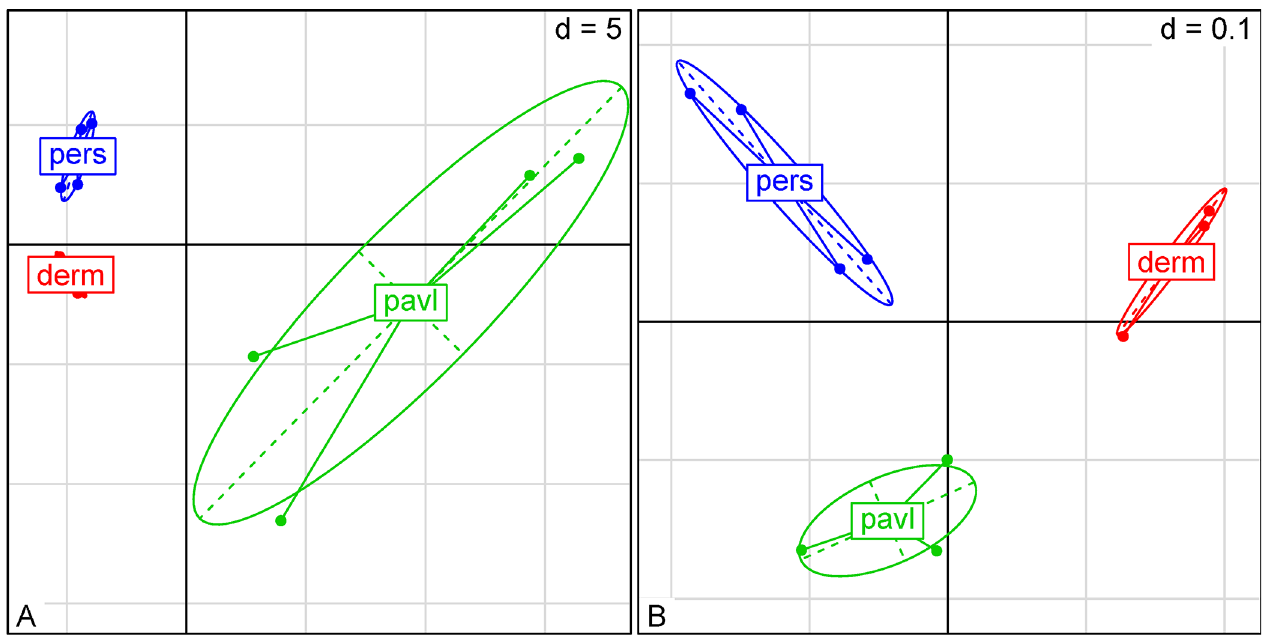
Fig 2. Between-class analysis plots for taxon-based distances. A) MDS plot based on PCA for 150 taxa with the largest share. Principal component analysis was performed using package “ ade4 ” with data scaling and centering. B) MDS plot based on the UniFRAC distance. Calculation of UniFRAC distance was performed using QIIME package. First and second principal components describe 40.69% and 32.82% of total variance